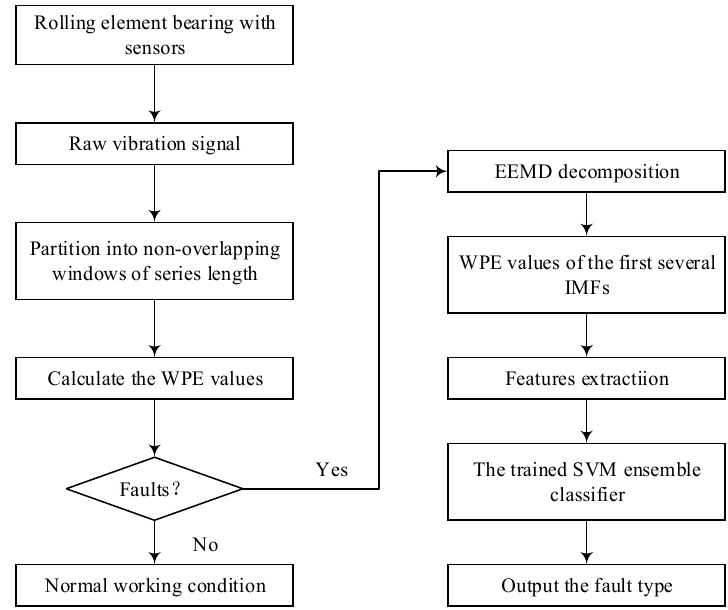
Figure 5. Flowchart of the proposed method.